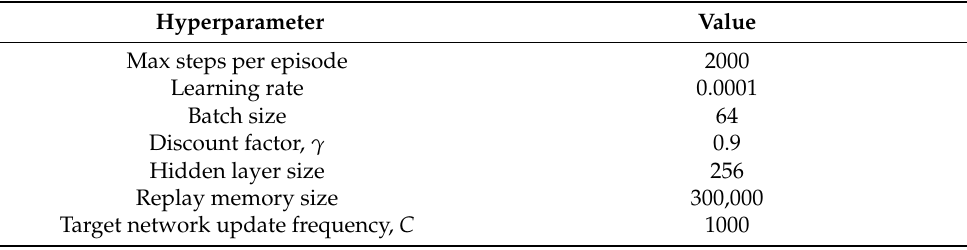
Table 4. List of hyperparameter values of